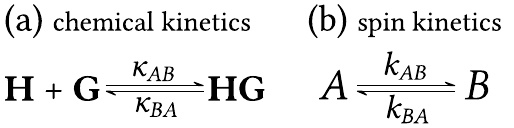
Figure 5. Two-state exchange with 1:1 host–guest binding. Schemes for ( a ) chemical kinetics and ( b ) corresponding spin kinetics of a nucleus located at the host